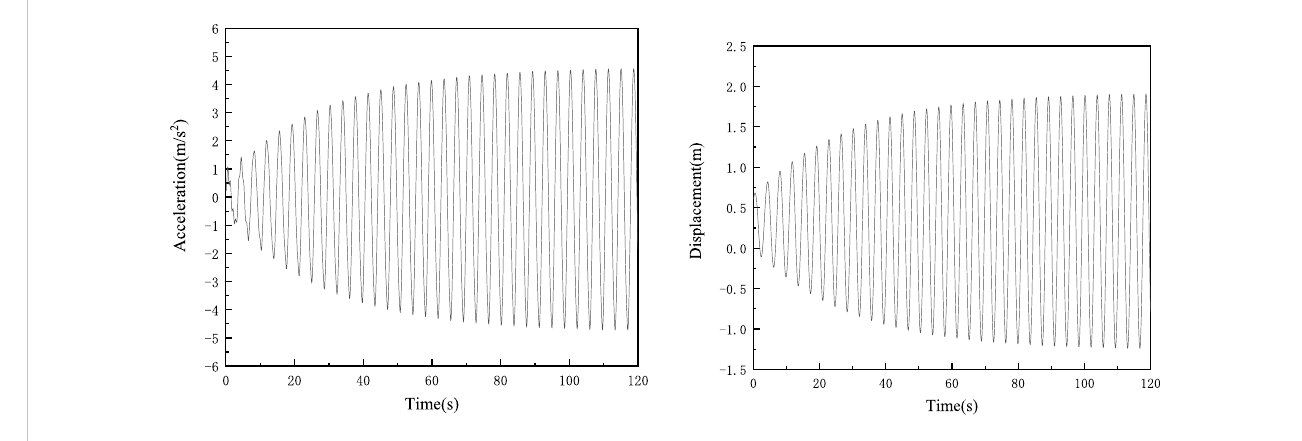
FIGURE 3 The acceleration and displacement response of wind turbine room under steady-state ice force.